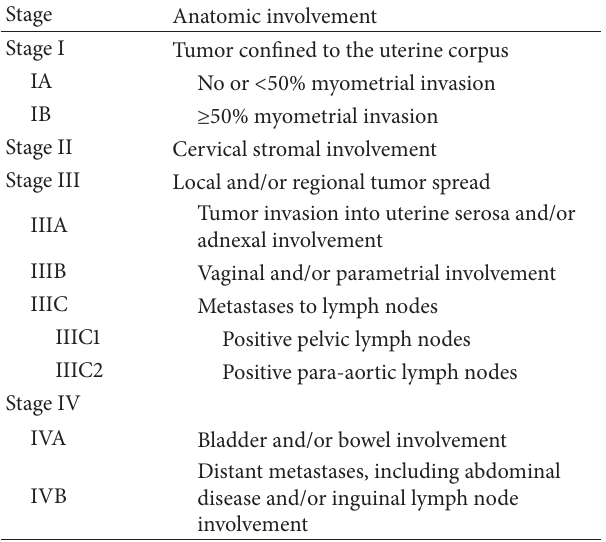
Table 2: 2009 FIGO staging system for endometrial